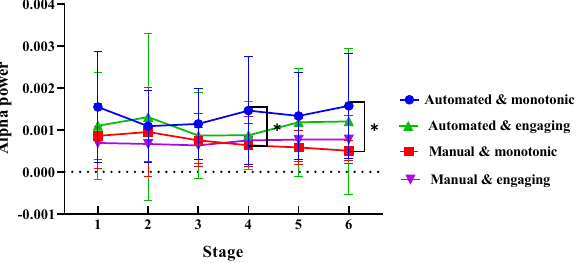
Figure 6. Interaction of driving modes, driving scenarios, and driving stages on α power (Note: * p < 0.05).